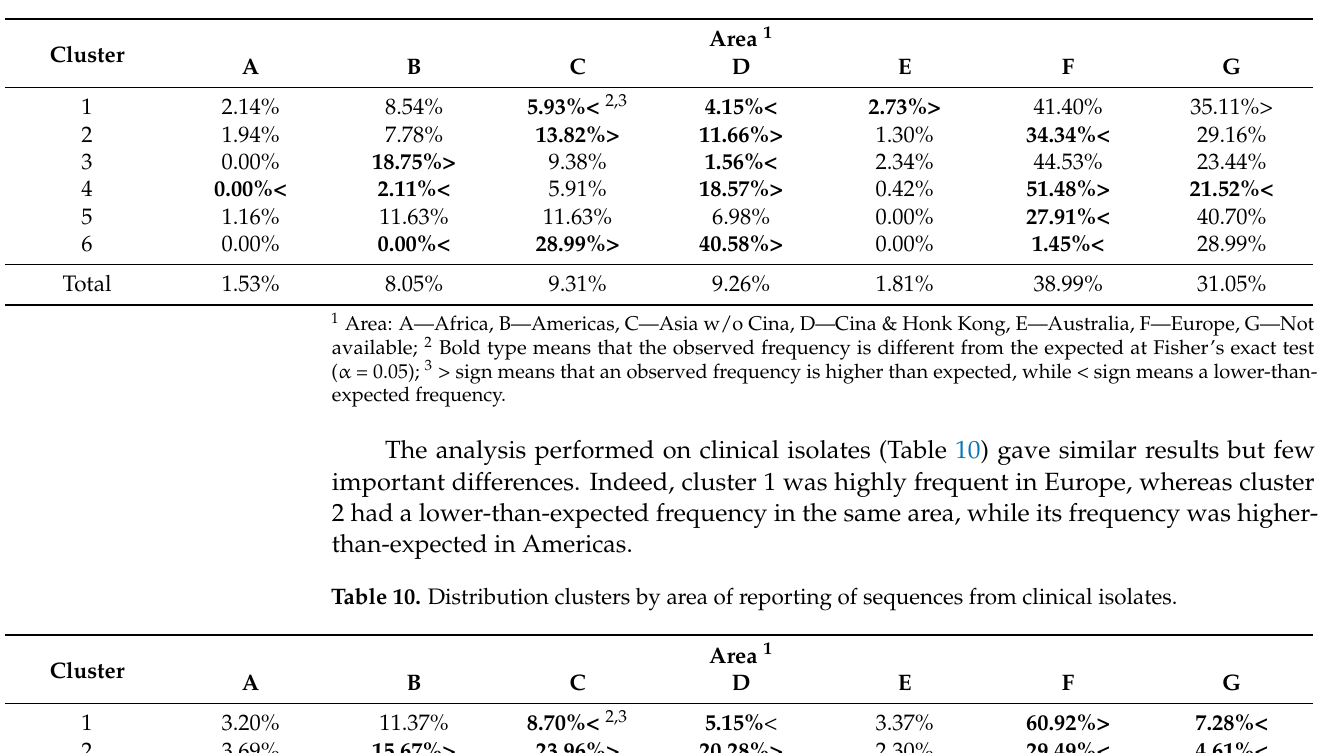
Table 9. Distribution clusters by area of reporting of all the sequences.